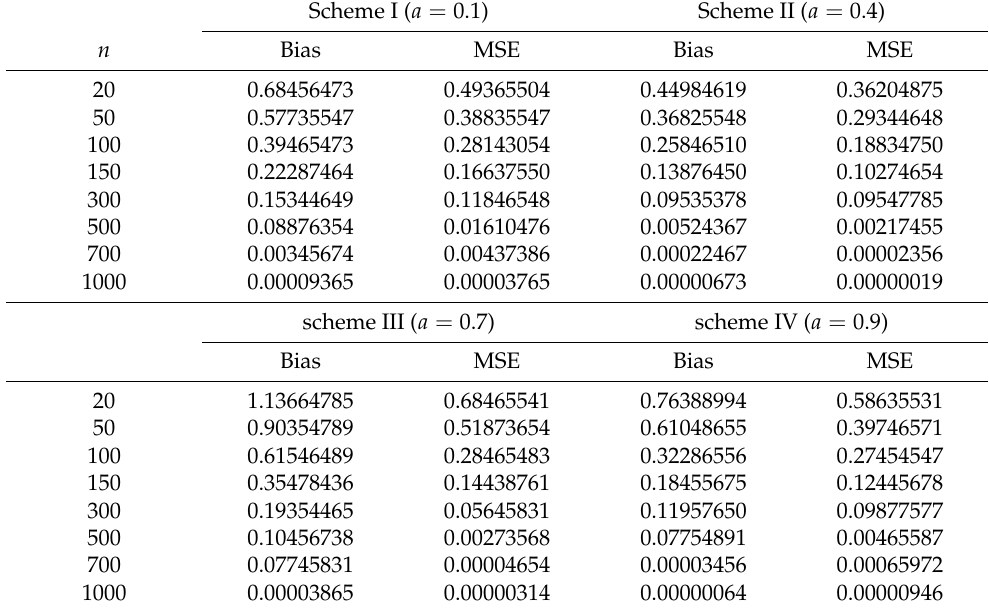
Table 2. Simulation results for DWPLT parameters using the MoE